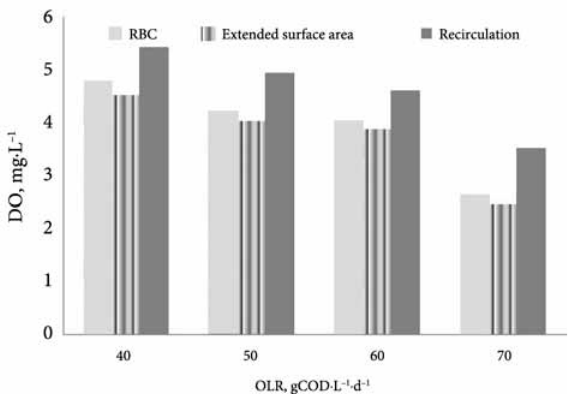
Fig. 5. DO level with respect to OLR for RBC, extended surface and recirculation